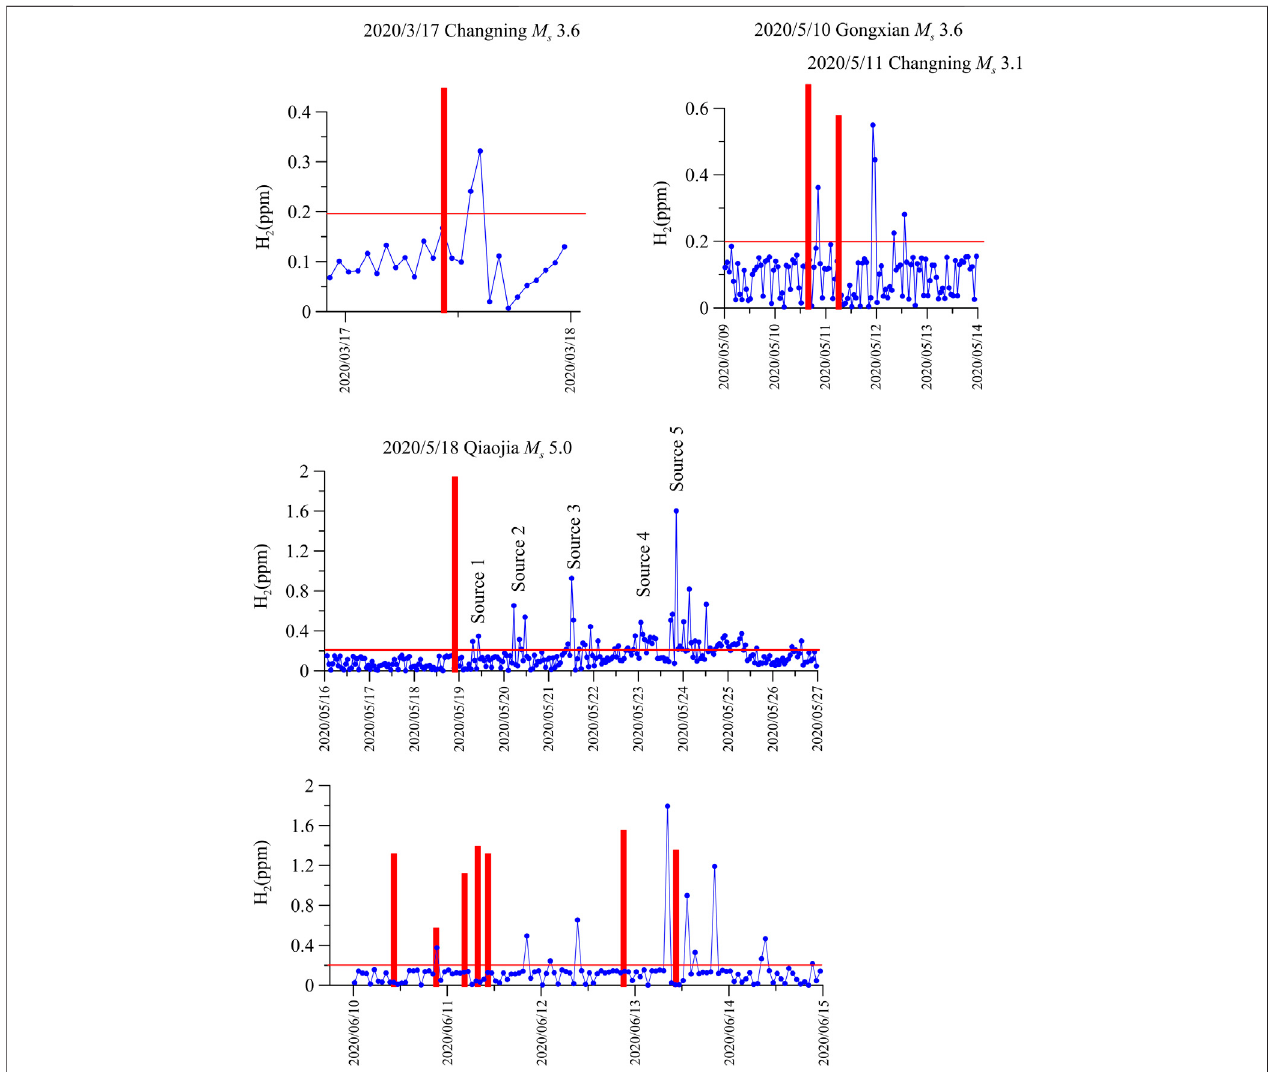
FIGURE 10 | Precursor anomalies induced by arti fi cial